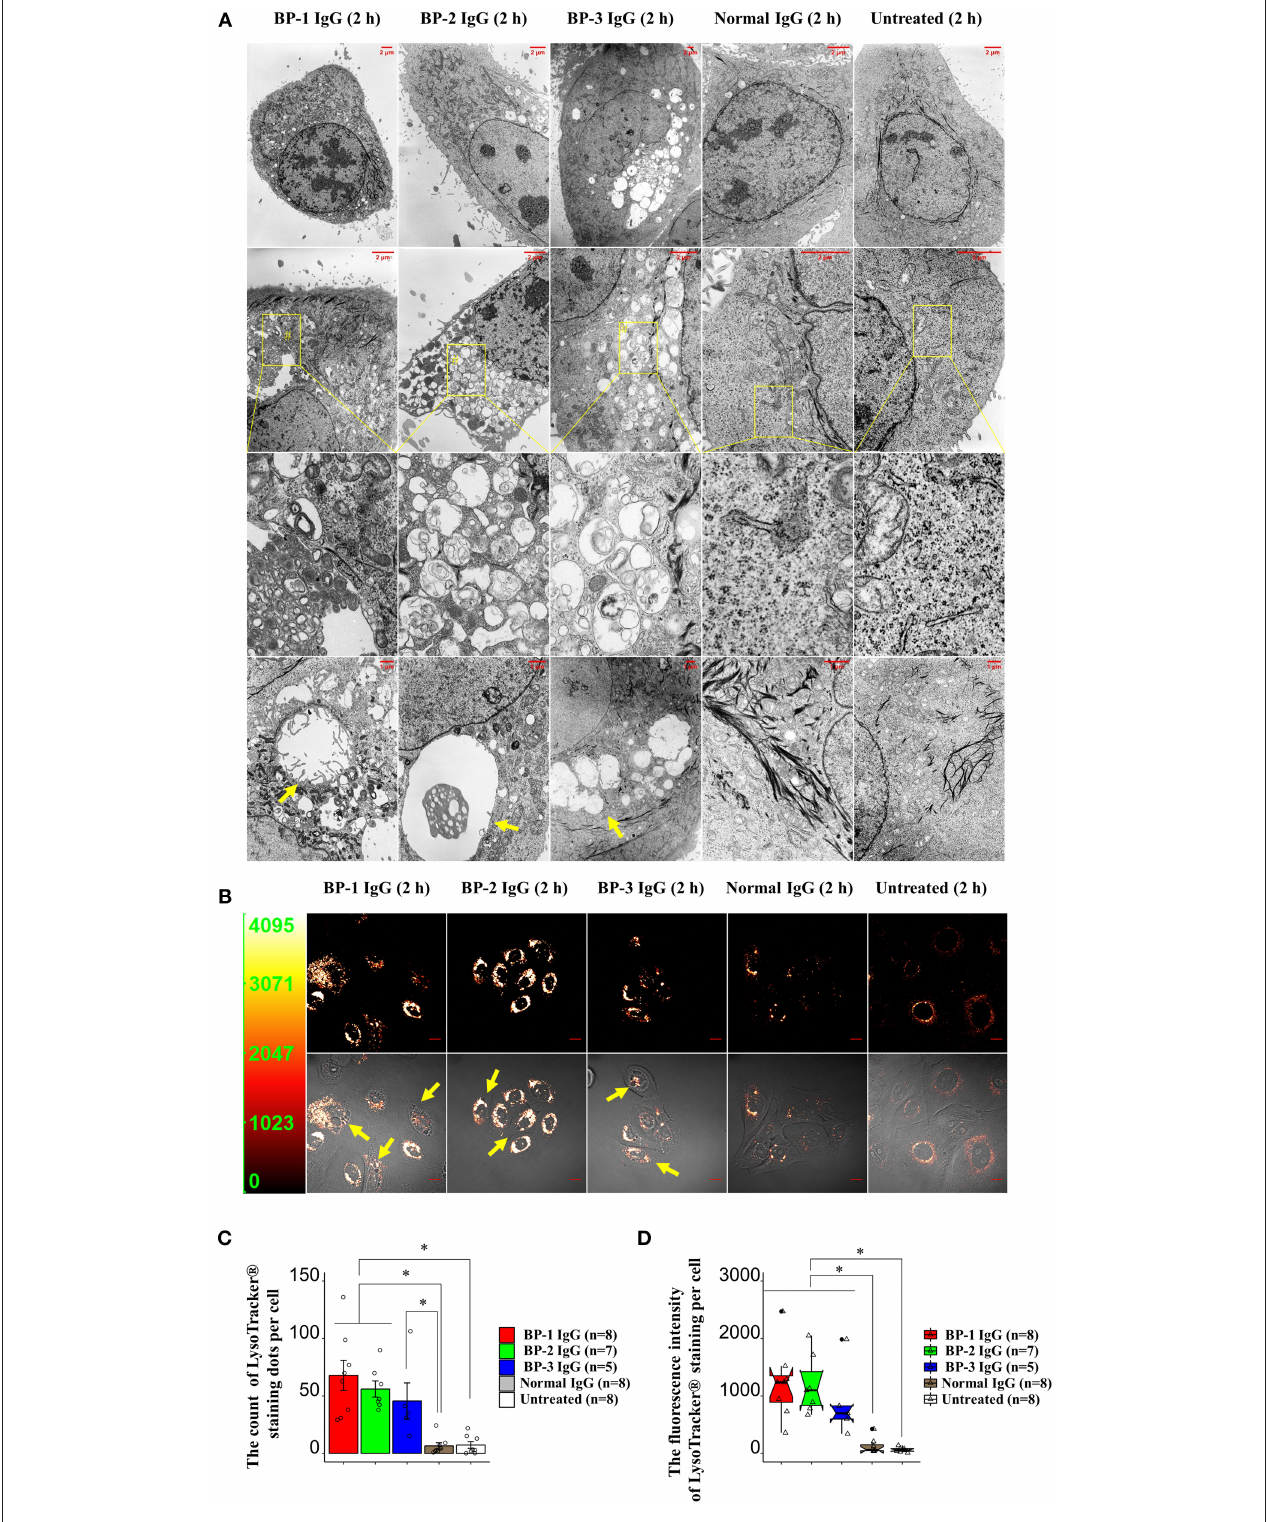
FIGURE 5 | Changes in the morphology of NHEKs stimulated with BP IgG. (A) TEM images of NHEKs stimulated with BP IgGs (BP-1, BP-2, and BP-3) or normal IgG for 2h. Zoomed-out images labeled with the # symbol shows vacuolar structures containing myelin-like structures. Vacuolar structures are indicated with